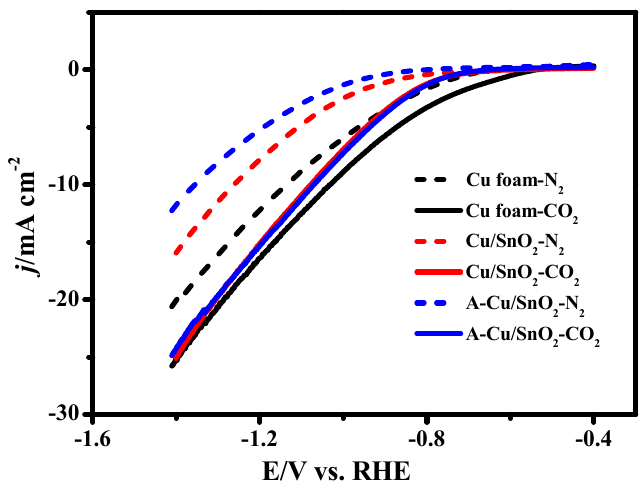
Figure 5. The linear scan voltammetry (LSV) tests on Cu foam, Cu / SnO 2 and A-Cu / SnO 2 with a potential range from 0.2 V to − 1.4 V (vs. reversible hydrogen electrode—RHE) at a scan rate of 50 mV / s in a N 2 -saturated and a CO 2 -saturated 0.1 M KHCO 3 electrolyte.